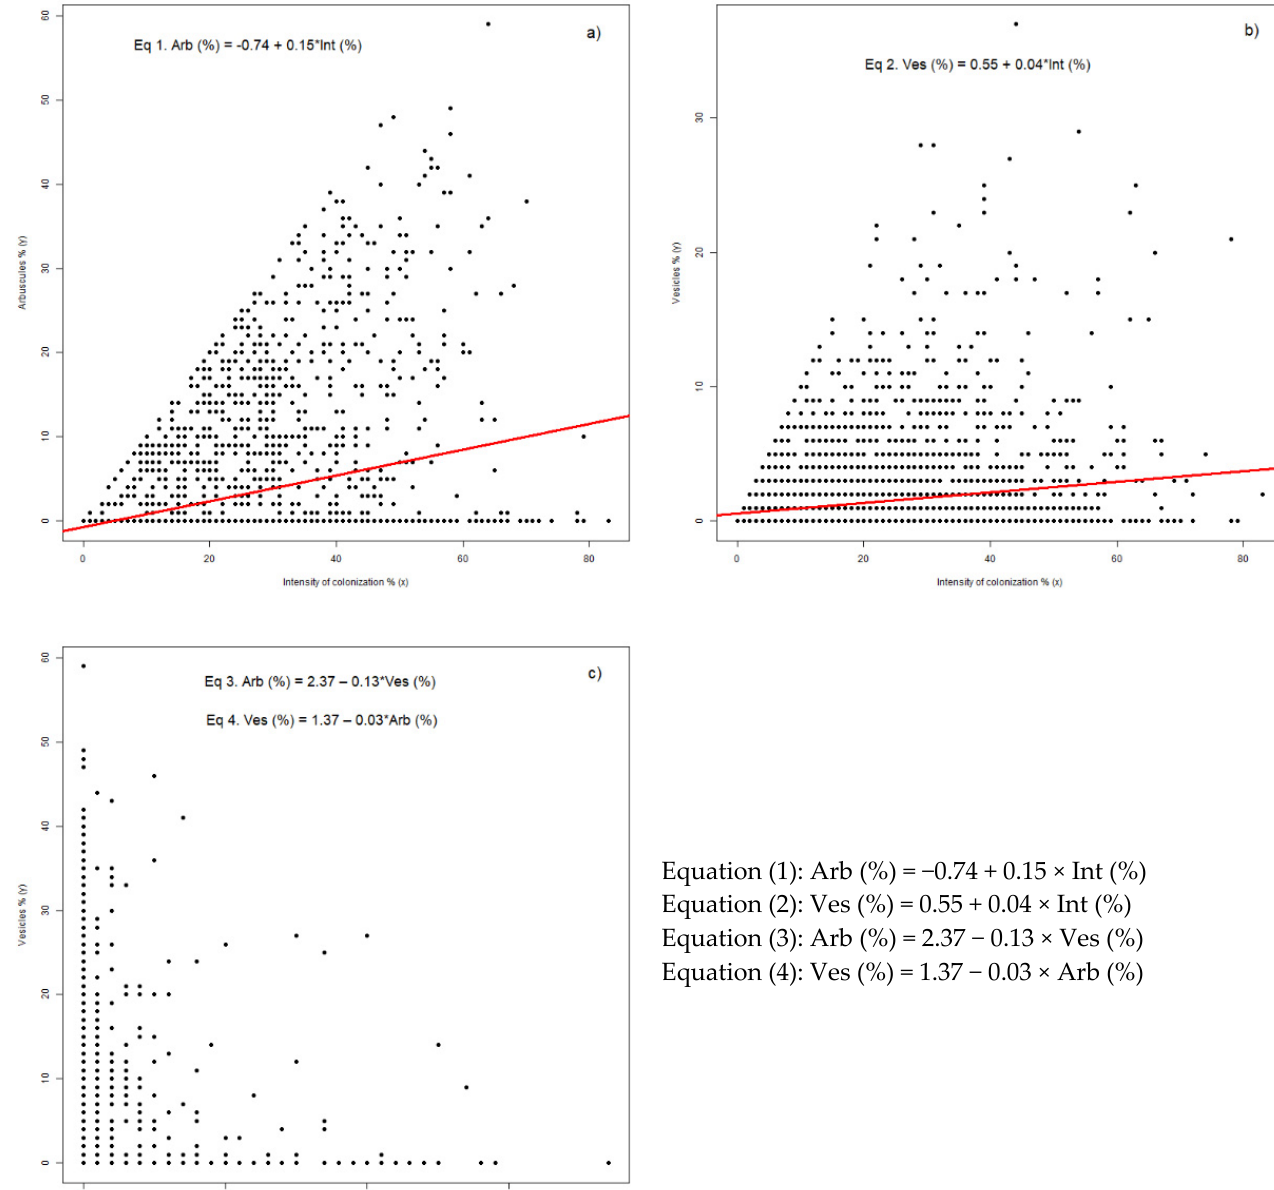
Figure 3. Interdependency between colonization parameters in F. rubra involved in the direction of colonization strategy: ( a ) Arbuscules vs. Intensity of colonization; ( b ) Vesicles vs. Intensity of colonization; ( c ) Arbuscules vs. Vesicles. Legend: Int—colonization intensity; Arb—arbuscules abundance; Ves—vesicles abundance; * means multiply.